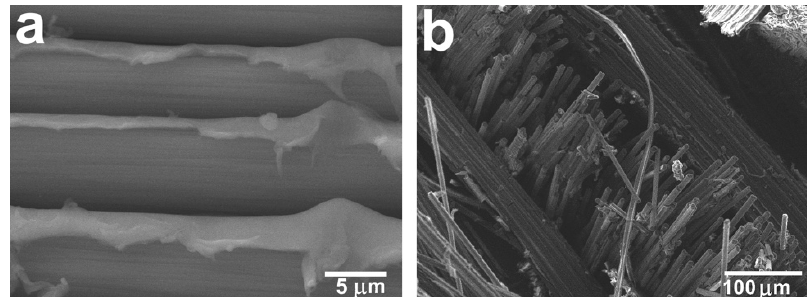
Figure 7. The structure of the CF/PSU composites (60/40 wt %) reinforced with the initial carbon fibers after tensile tests: ( a ) high-magnification image of the interfiber space; ( b ) low-magnification image of the fractured surface [43].